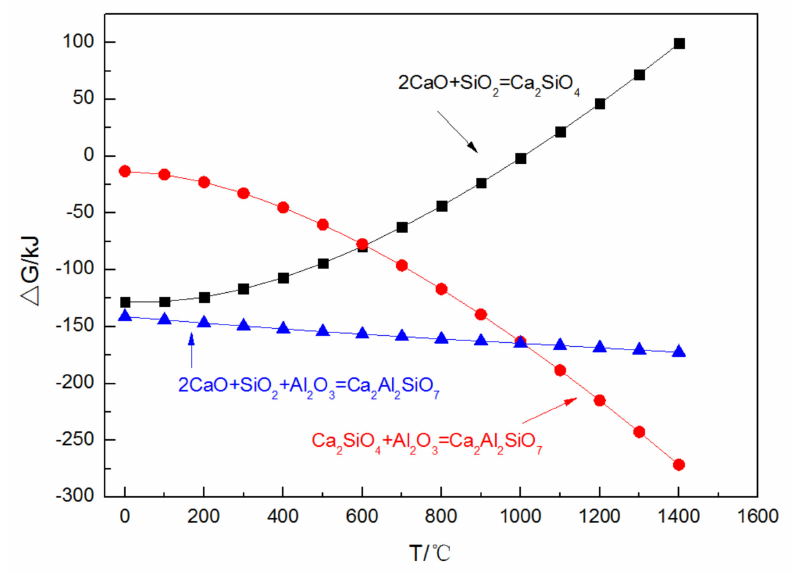
Figure 3. Influence of temperature on ∆ G in Formulas